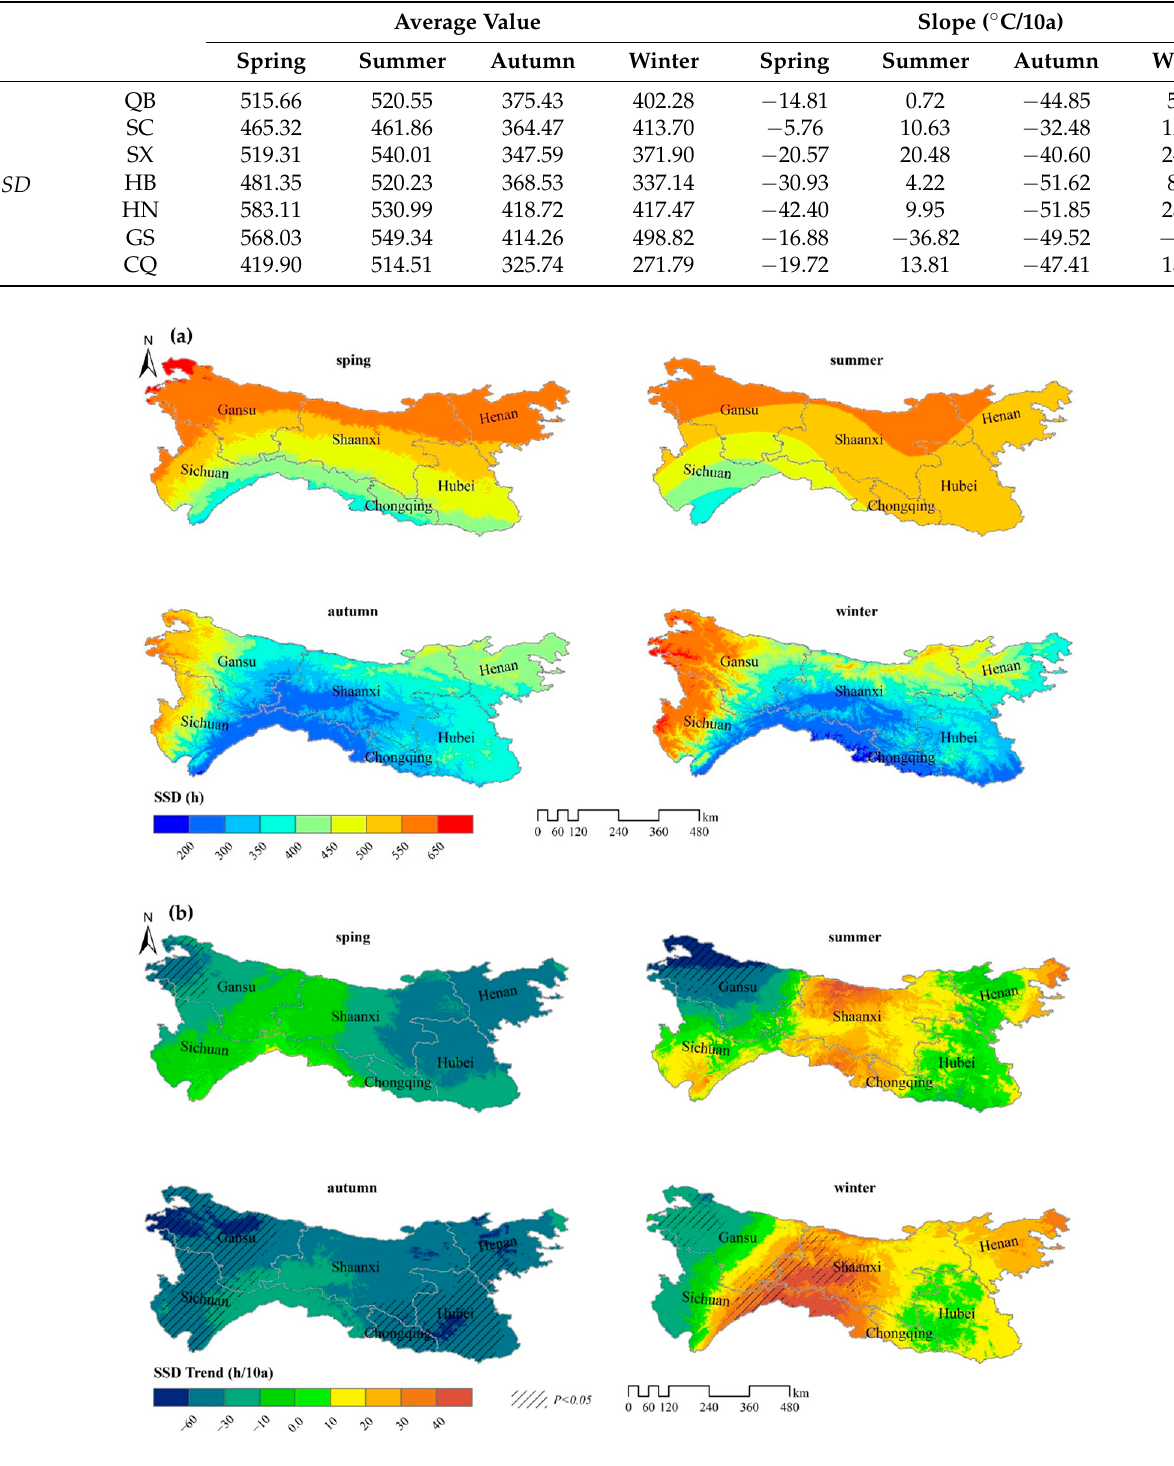
Figure 11. Change of seasonal average SSD spatial pattern in the QBM from 2000–2020. ( a ) Seasonal average; ( b ) Seasonal change trend rate.